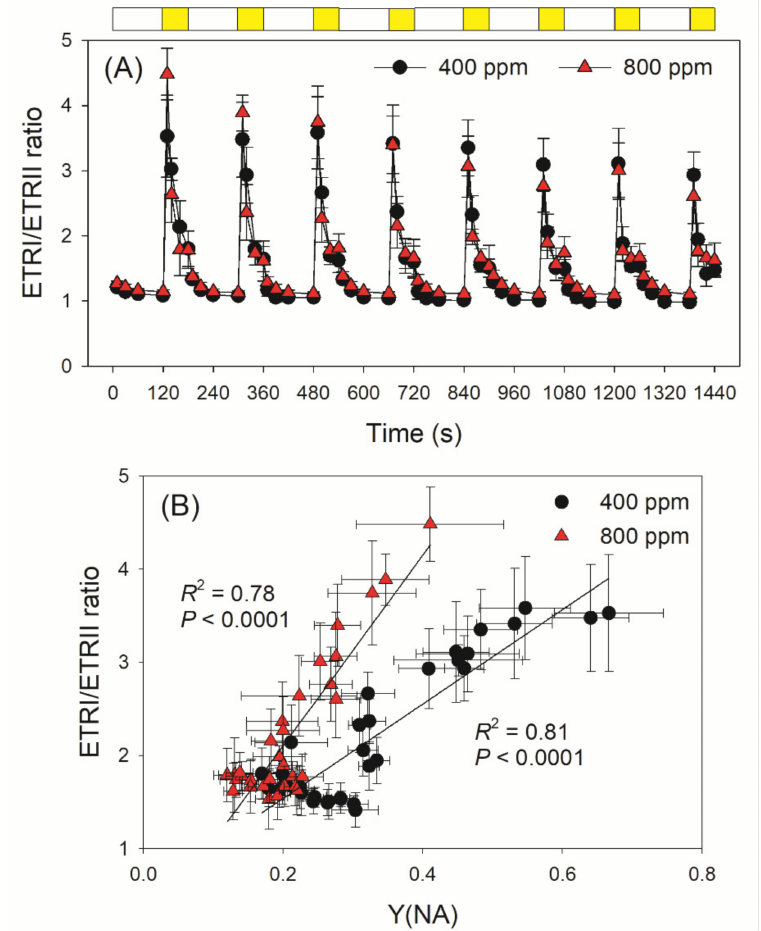
Figure 5. Changes in ETRI/ETRII ratio under fluctuating light and its relationship to Y(NA) in high-light phases. ( A ) Change in the ratio of ETRI/ETRII during fluctuating light alternating between 59 and 1809 µ mol photons m − 2 s − 1 in Arabidopsis leaves measured in 400 and 800 ppm CO 2 ; ( B ) Relationship between the ETRI/ETRII ratio and Y(NA) during the high light phase of fluctuating light treatments. Data are shown as means ± SD (n = 5). White bars indicate low light (59 µ mol photons m − 2 s − 1 ); yellow bars indicate high light (1809 µ mol photons m − 2 s − 1